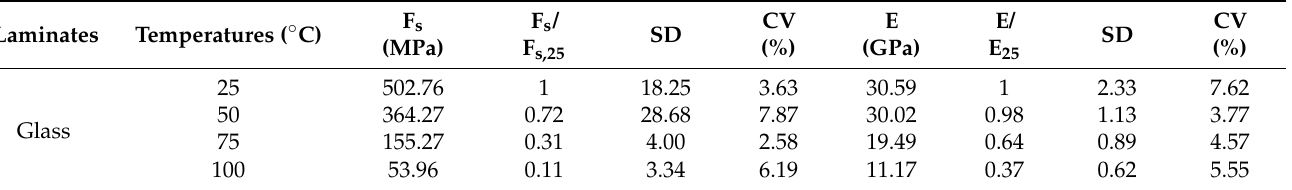
Table 4. Flexural strength (F s ) and modulus (E) properties of bidirectional glass laminates under different temperatures.